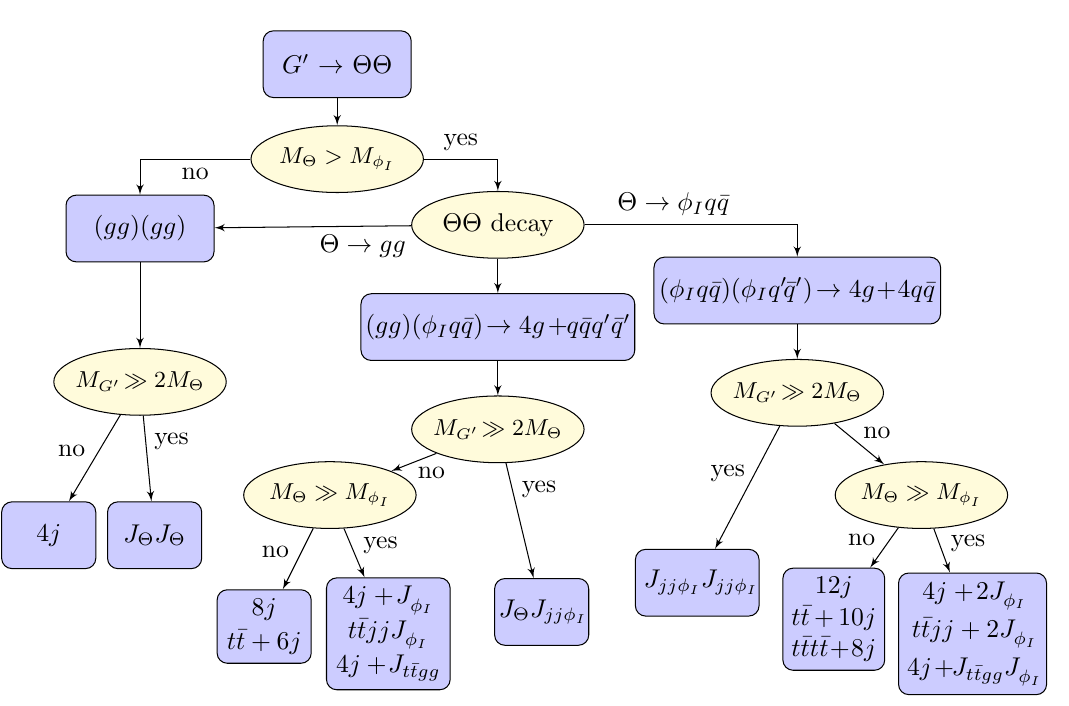
Figure 13 . Same as (cid:12)gure 11, except that the (cid:12)nal states shown here arise from the pp (cid:2)(cid:2)